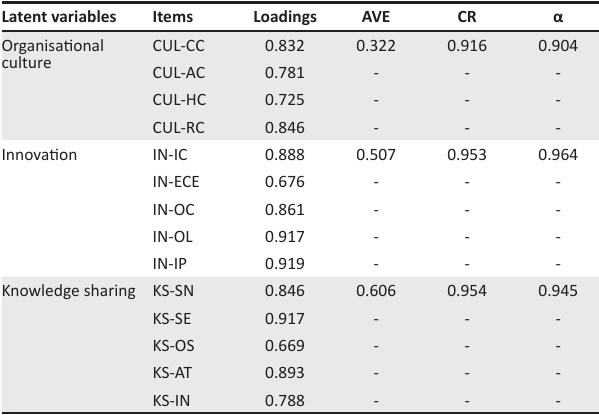
TABLE 2: Measurement model: Second-order latent variables. Latent